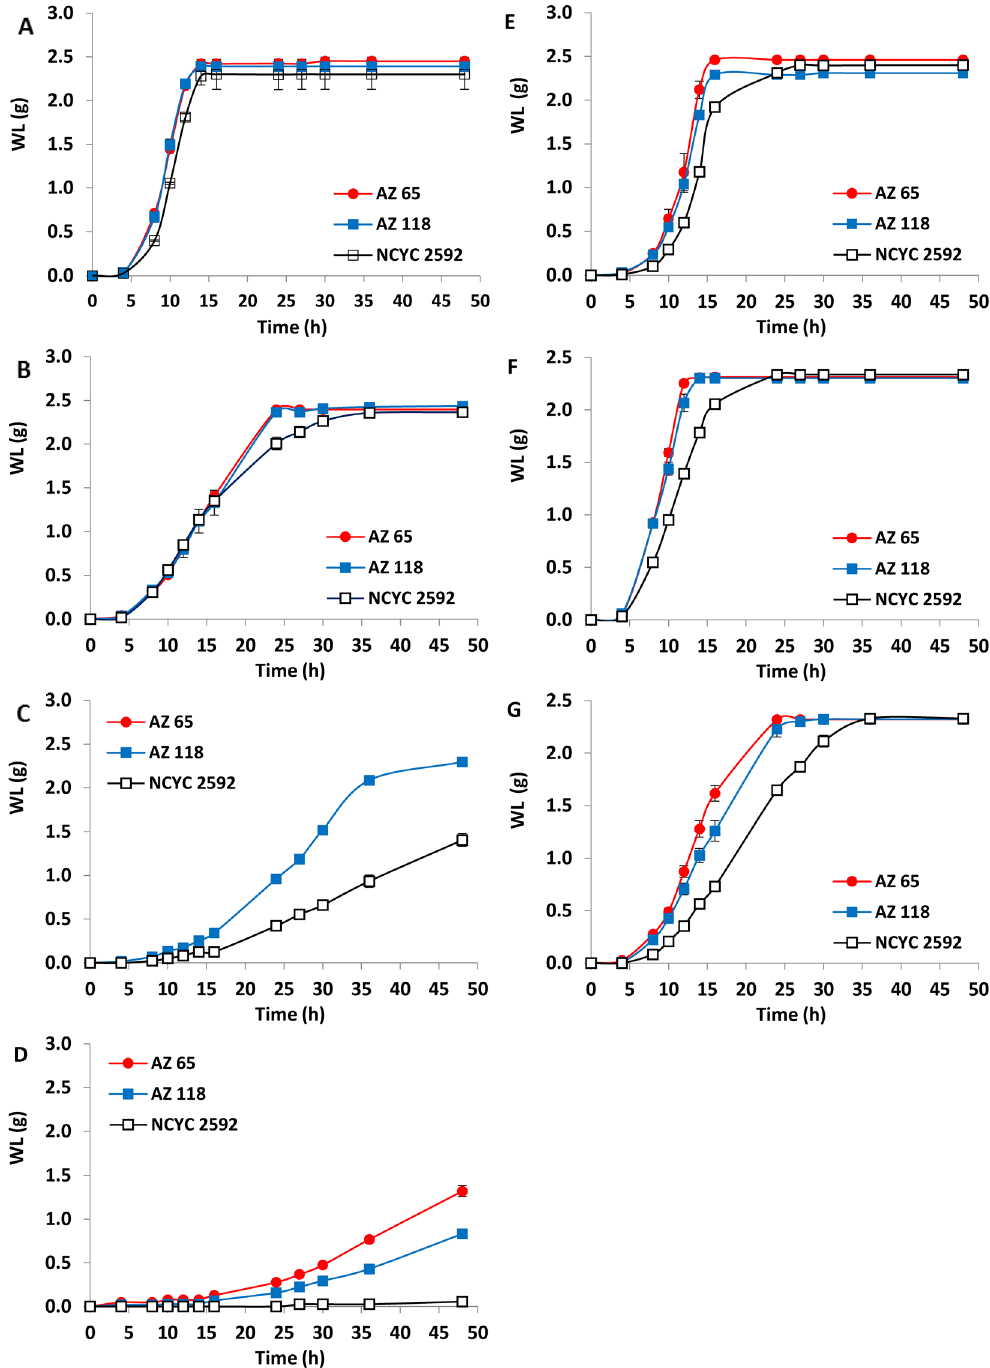
Figure 2. Fermentation performance of two marine yeast strains when exposed to salt stress using YPD media dissolved in different saline solutions ( A ) ROW, ( B ) NaCl 3%, ( C ) NaCl 6%, ( D ) NaCl 9%, ( E ) SW, ( F ) SSW, ( G ) 2X SSW. AZ65 & AZ118 are two marine S. cerevisiae strains. NCYC2592 is a terrestrial S. cerevisiae strain used as a reference for comparison. Weight loss as a result of CO 2 release from MFVs was measured during the fermentation at different time intervals to assess the fermentation rate of each yeast strain. The experimental error bars represent the standard deviation of the three